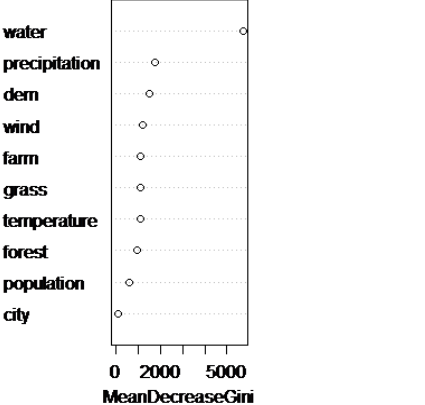
Figure 6. Importance of socio-ecological variables.